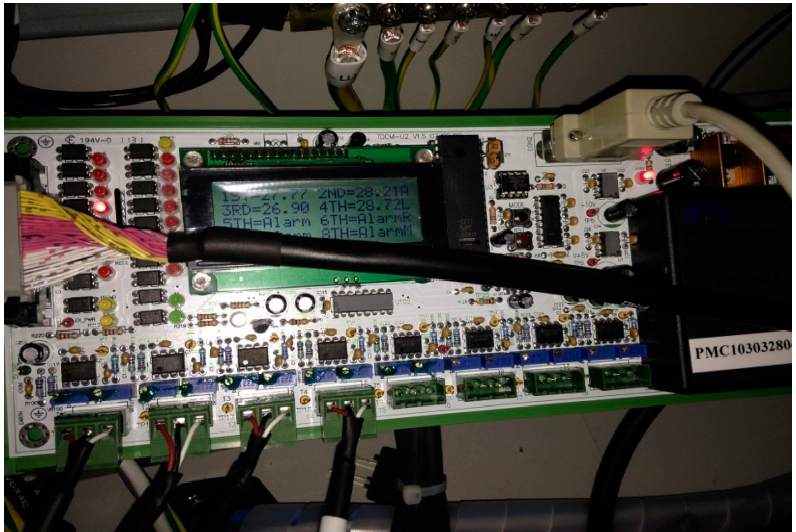
Figure 8. Temperature rises with time measured at four sensors.